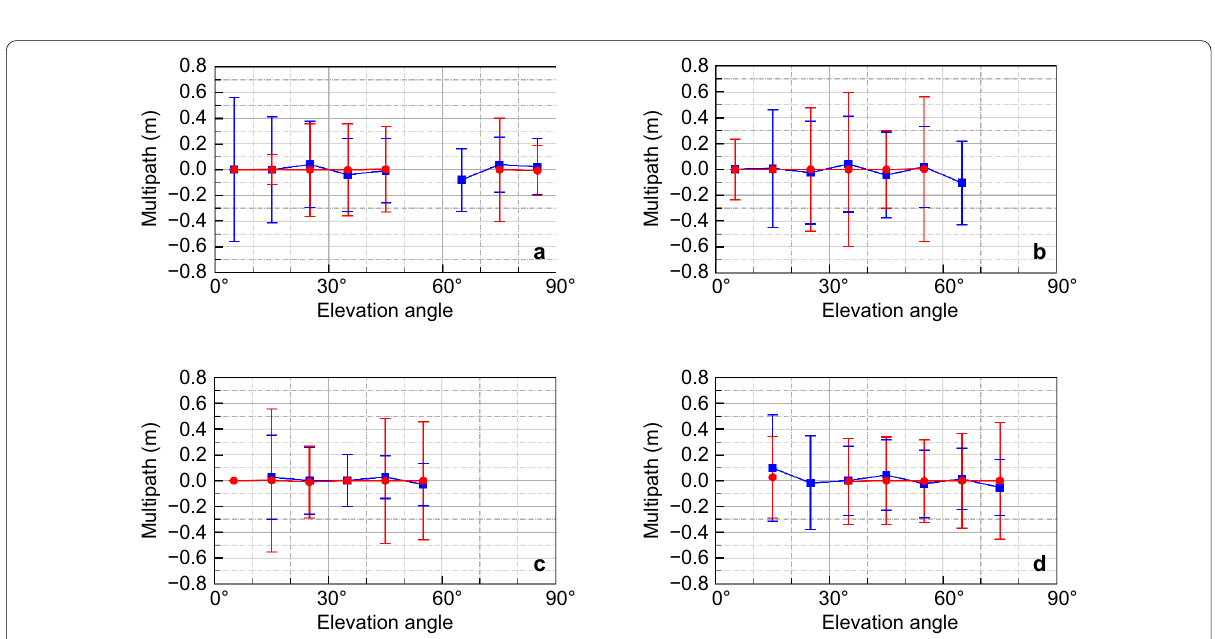
Fig. 10 Averaged multipath effects with standard deviation at different elevation angles for GPS in ( a ), GLONASS in ( b ), Galileo in ( c ), and BDS in ( d ) for the stationary receiver (blue line) and the moving receiver (red line). The error bars around the data points represent the